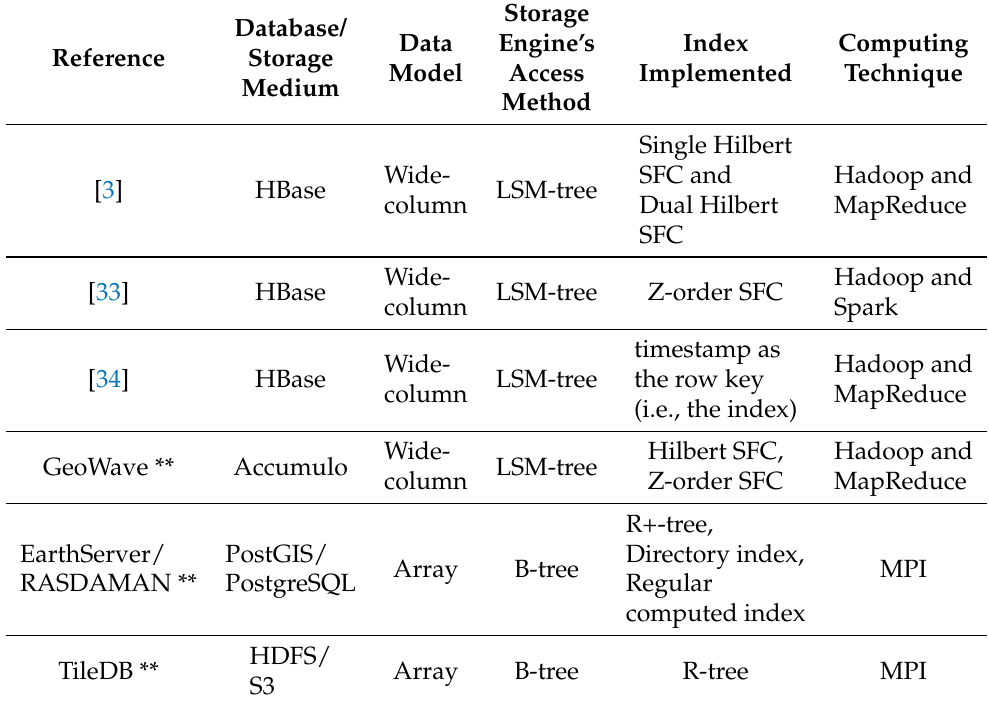
Table 3. Shared-nothing architecture-based PCDM